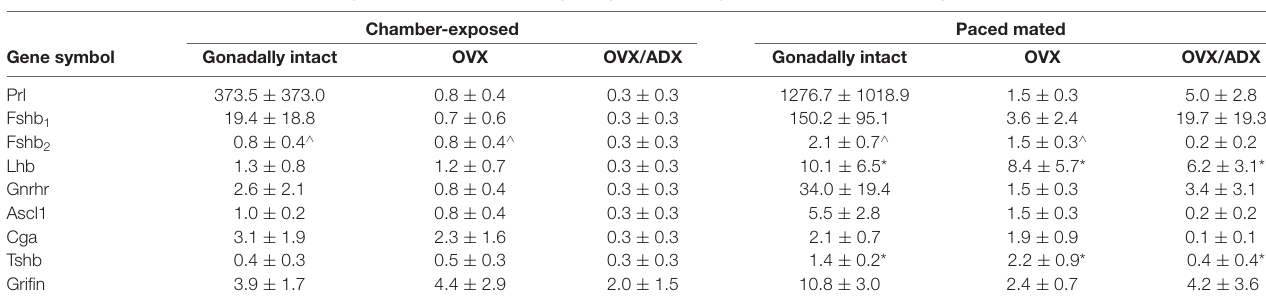
TABLE 3 | qPCR results for nine genes that were significantly ( > 2-fold change) up-regulated in the midbrain of rats that were paced mated compared to yoked control rats that were only exposed to the paced mating chamber ( n = 3/group). Relative expression differences via qPCR (mean ± SEM) vs. mean of control rat expression Chamber-exposed Paced